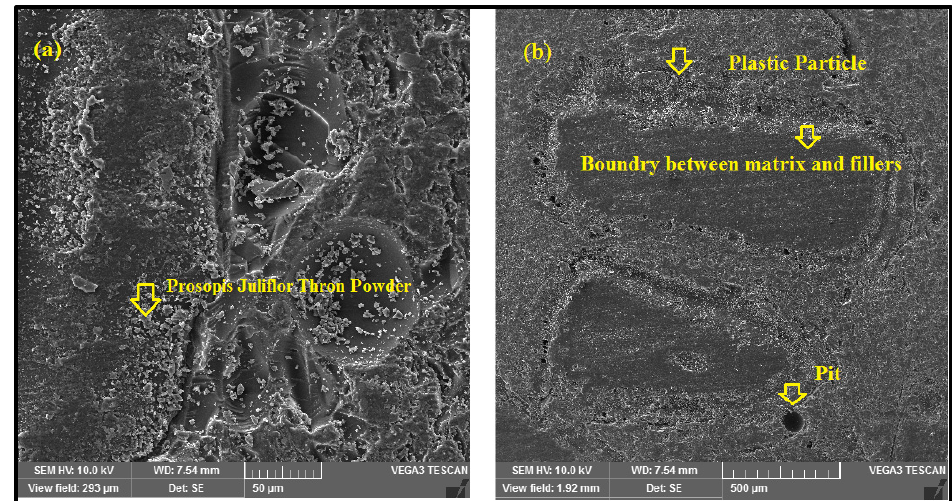
Figure 9. ( a ). SEM image with 50 µm magnification ( b ). SEM image with 500 µm magnification.